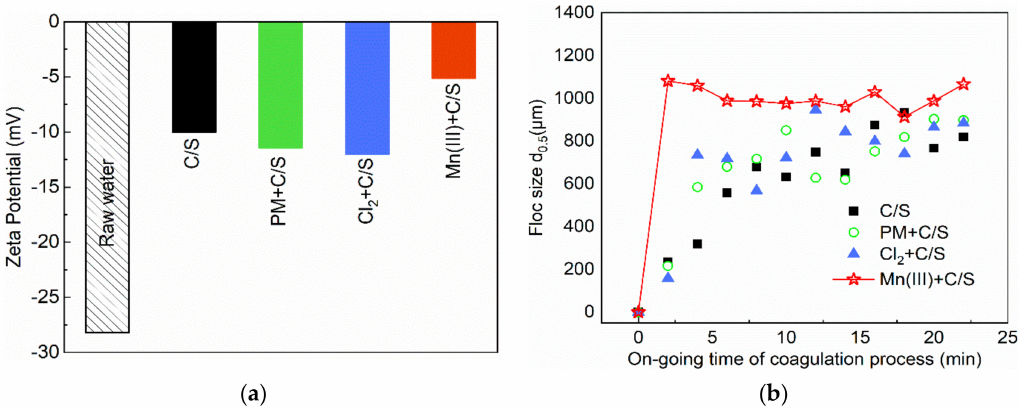
Figure 6. Time dependent profile of ( a ) zeta potential and ( b ) floc size at the coagulation stage for di ff erent processes.